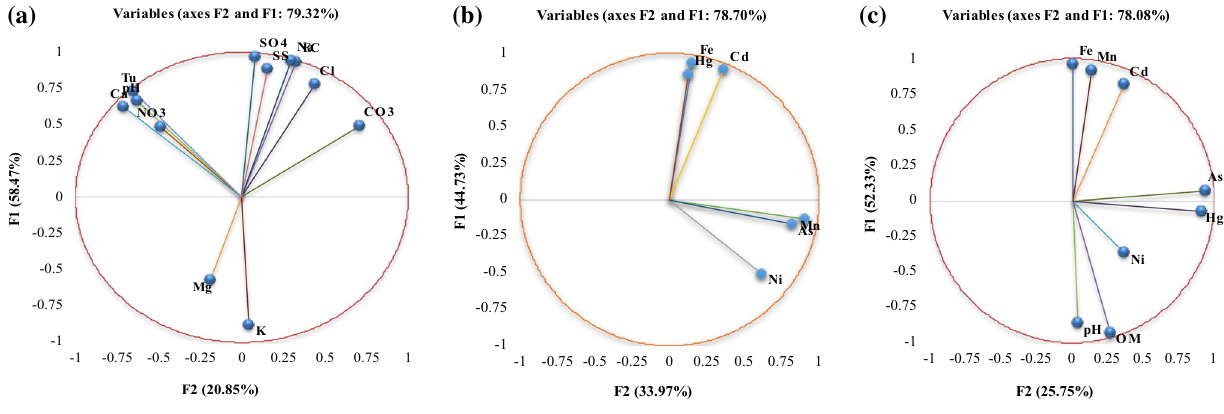
Fig. 7 Principal component analysis (PCA) for: a Physical parameters, major ions of water samples; b Heavy metal of water samples and ( c ) Physicochemical parameters of sediment samples